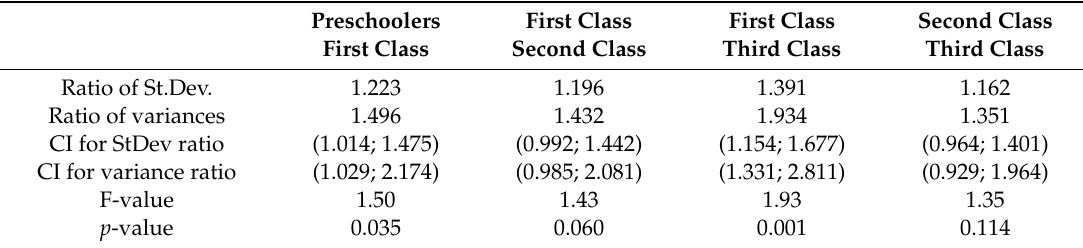
Table 4. F-test for two variances within the target